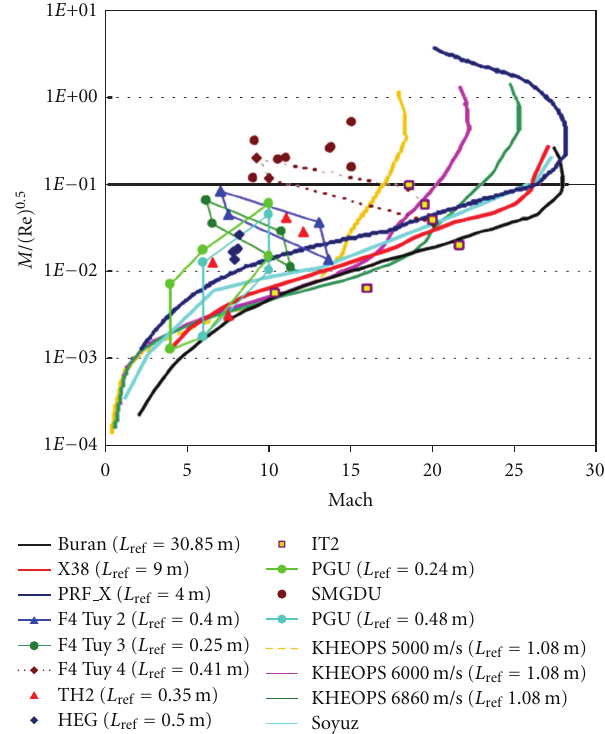
Figure 6: Capabilities (Mach/(Re) 1 / 2 as function of Mach number) of di ff erent facilities (F4, HEG, TH2) comparing to suborbital entries of di ff erent vehicles